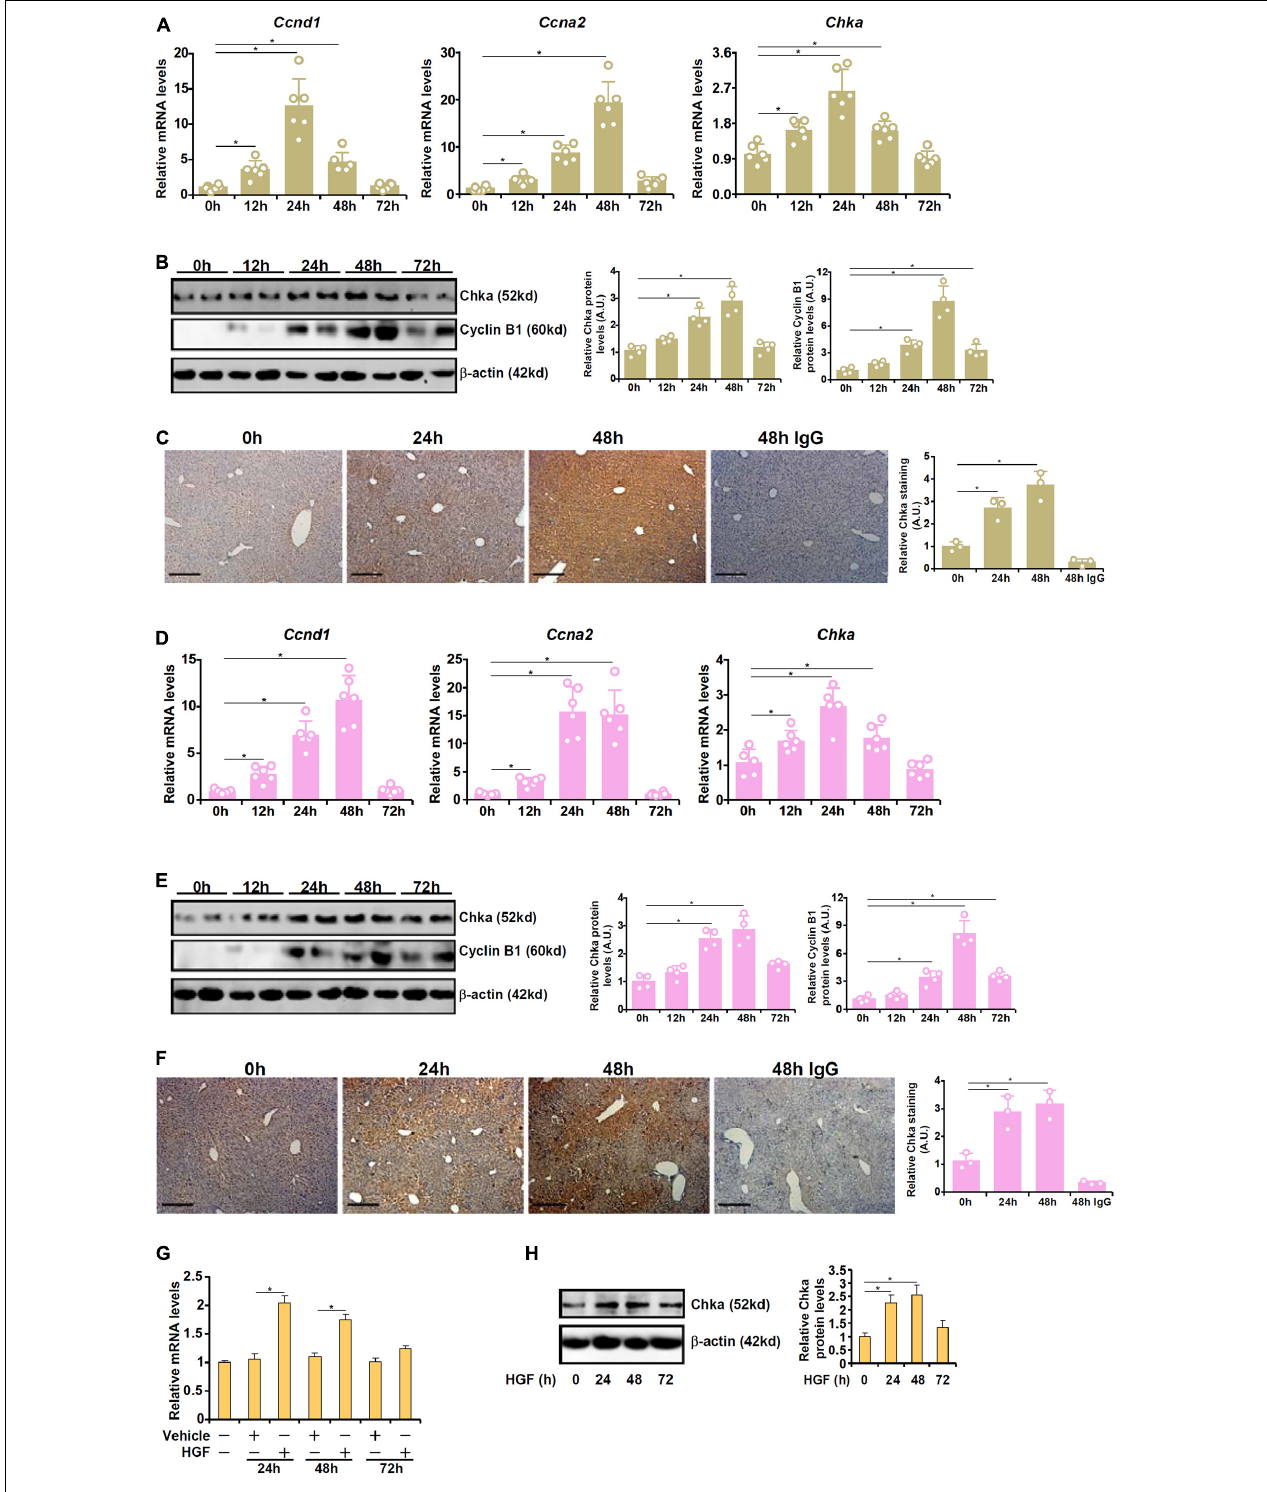
FIGURE 1 | Choline kinase alpha expression levels are up-regulated in models of liver regeneration in vivo and in vitro . (A–C) C57B6/L mice were subjected to 2/3 PHx and sacrificed at indicated time points. Chka expression was examined by qPCR (A) , western blotting (B) , and immunohistochemical staining (C) . (D–F) C57B6/L mice were subjected to APAP injection (300 mg/kg) and sacrificed at indicated time points. Chka expression was examined by qPCR (D) , Western blotting (E) , and immunohistochemical staining (F) . (G,H) Primary hepatocytes were isolated from C57B6/L mice and treated with or without HGF. Chka expression levels were examined by qPCR and Western blotting. * p <